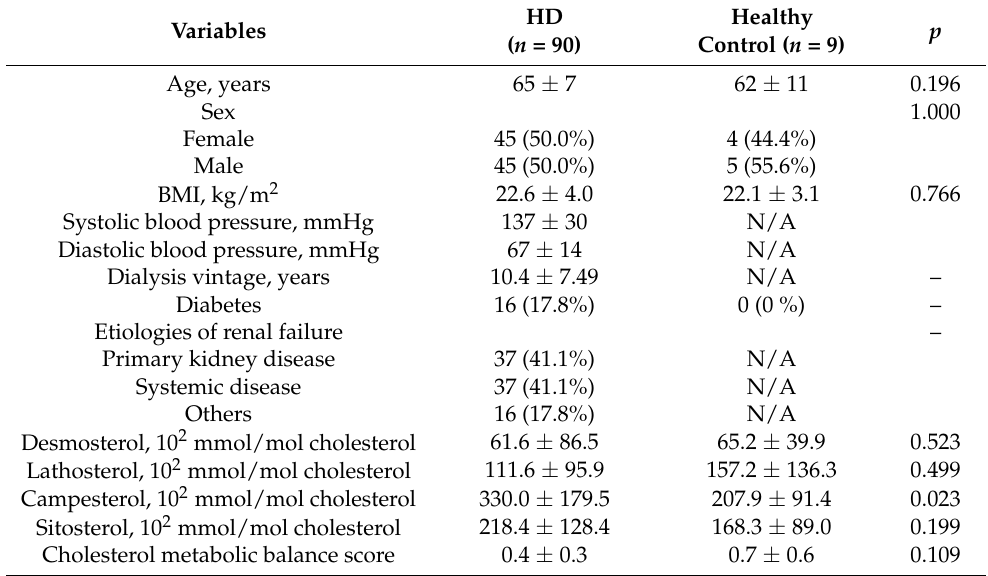
Table 1. Baseline characteristics in hemodialysis (HD) patients and healthy controls ( n = 99).